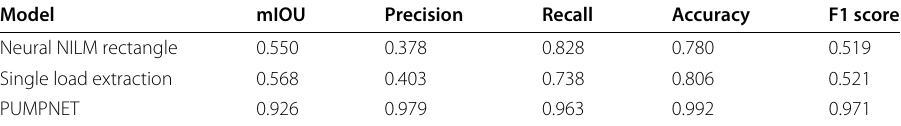
Table 1 Performance comparison between baseline models and PUMPNET Model mIOU